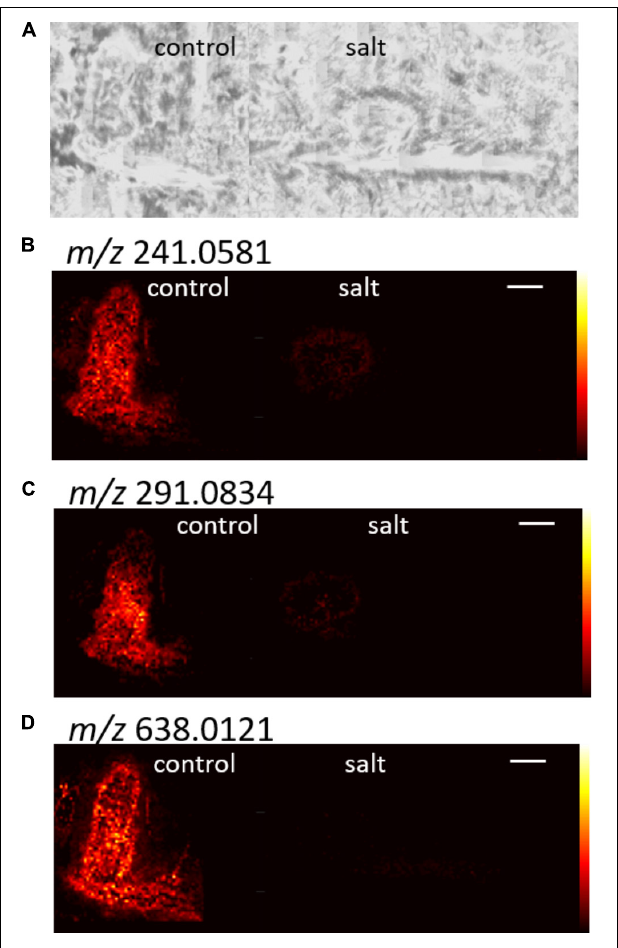
FIGURE 5 | Example images for control m/z with AUC values above 0.75. The optical image is shown in (A) and (B–D) show three different m/z . CHCA was the matrix for all images shown. The white scale bar indicates 1 mm.